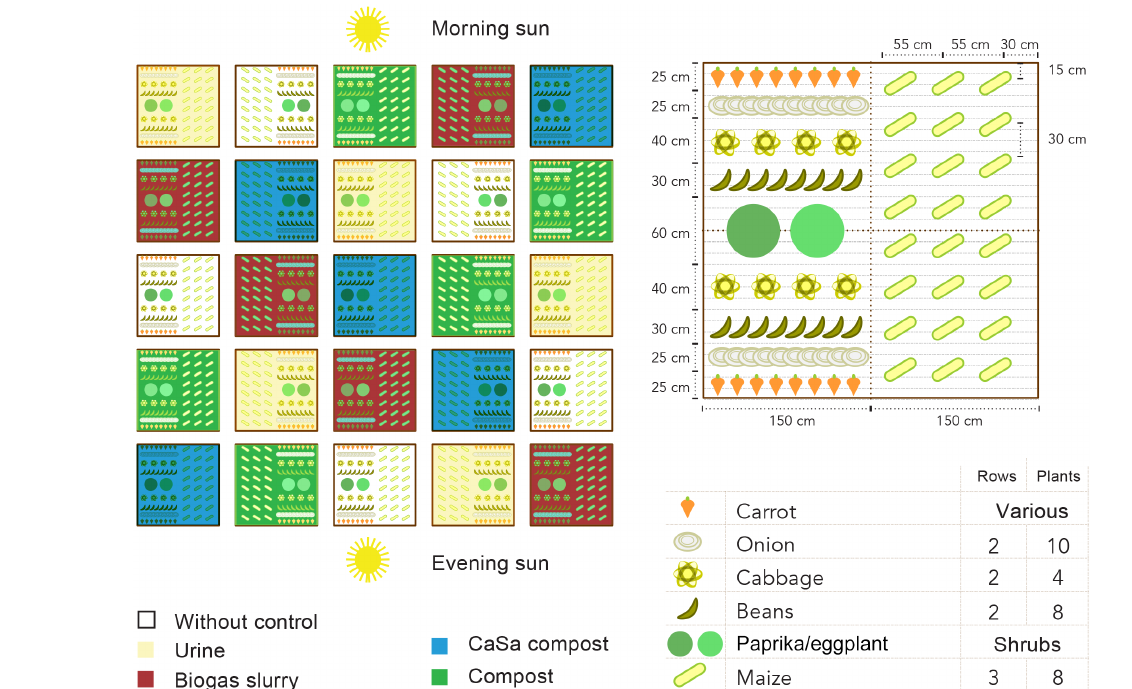
Figure 1. The experiment design: the plots were arranged as a Latin rectangle with five columns and five rows (left panel) and each plot was divided into two 4.5m 2 sections for the cultivation of seven selected crops in an intercropping system (right panel); note that urine treatment was a posteriori excluded from the analysis due to technical